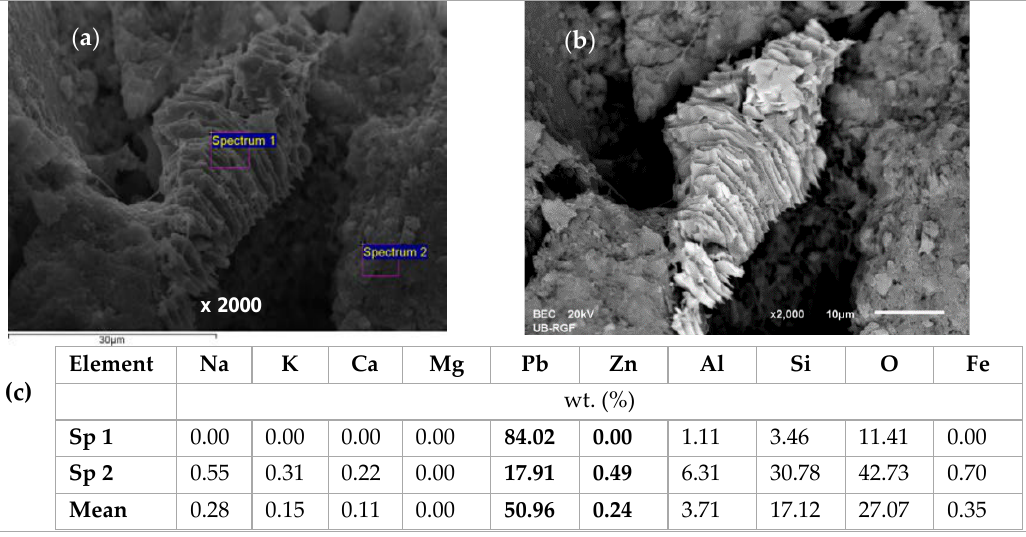
Figure 16 . SEM images of crystal for the (Pb + Zn) system and Pb/Zn = 1.07: ( a ) SE image x 2000 with two spectrums (Sp); ( b ) BSE image x 2000 ; ( c ) EDS analysis results.